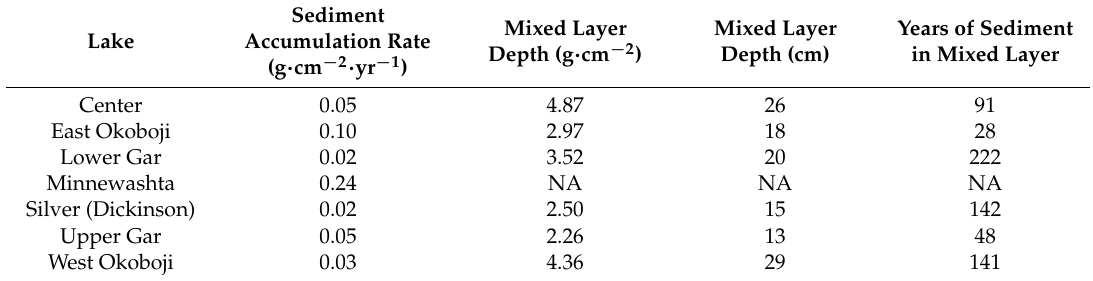
Figure 8. Semi-logarithmic plots of the unsupported 210 Pb activity versus cumulative sediment mass for Center Lake ( a ), East Okoboji Lake ( b ), Lower Gar Lake ( c ), Minnewashta Lake ( d ), Silver Lake (Dickinson) ( e ), and Upper Gar Lake ( f ). The dashed lines indicate the depths of the proposed mixed layers of sediments. Table 5. Sediment accumulation rate, depth of the mixed layer as a cumulative sum and in cm, and the number of years of sediment accumulation represented in the mixed layer. Lake Minnewashta did not show a mixed layer.